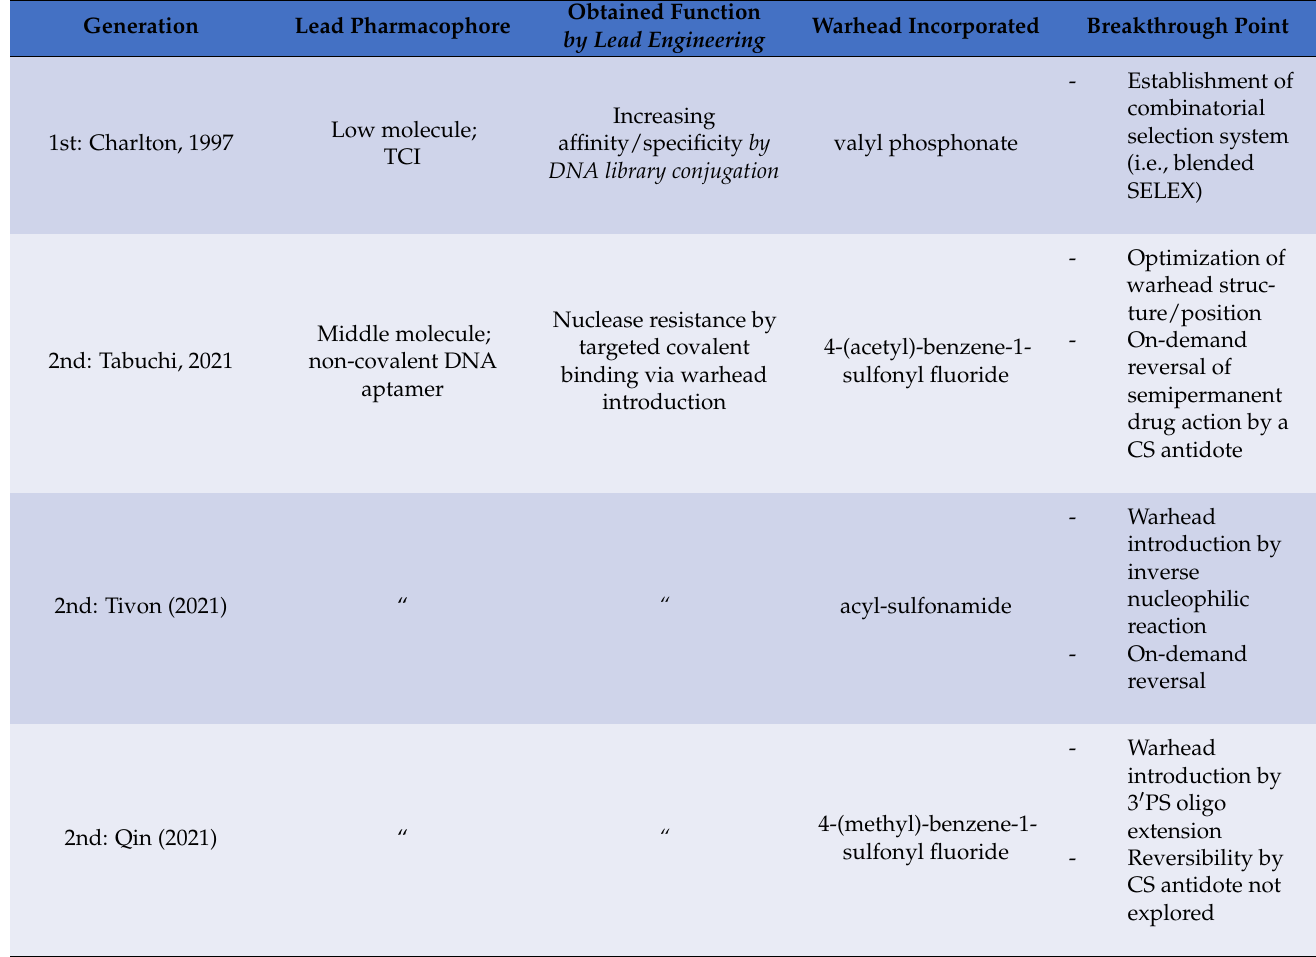
Table 2. A comparison of currently reported nucleotidic TCI. One first generation (DNA and RNA aptamers) original, and three second generation nucleotidic TCIs have been reported in the literature over 2021–2022. Some of the key differences are